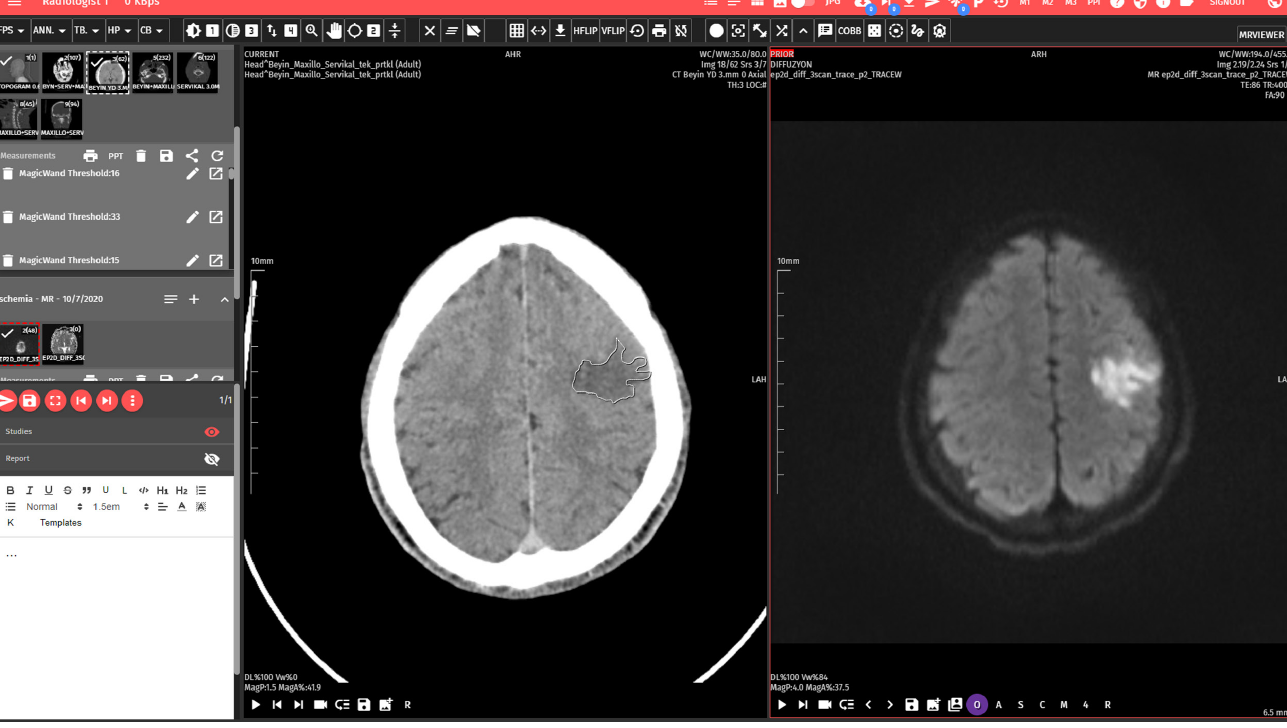
Figure 2. Data viewing and segmentation